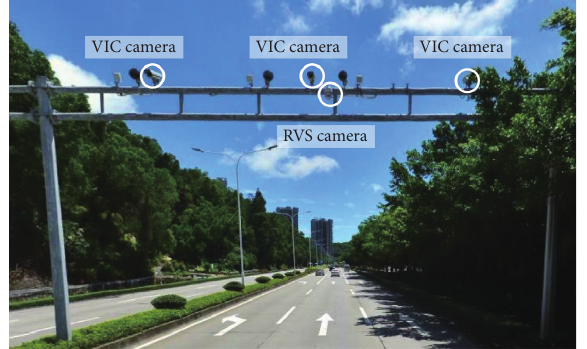
Figure 14: The camera systems in the experiment (from http:// map.qq.com).